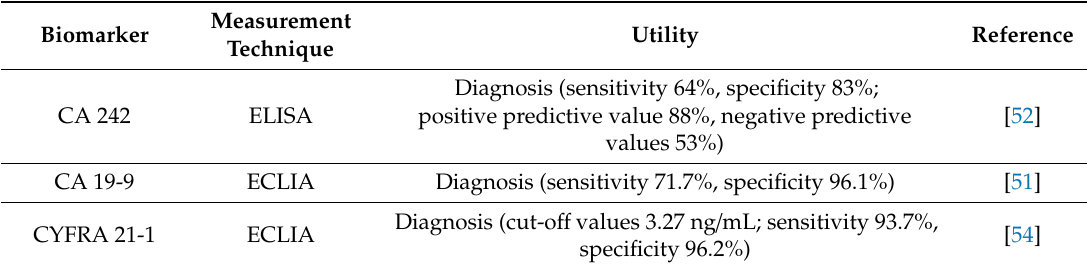
Table 2. Biomarkers for